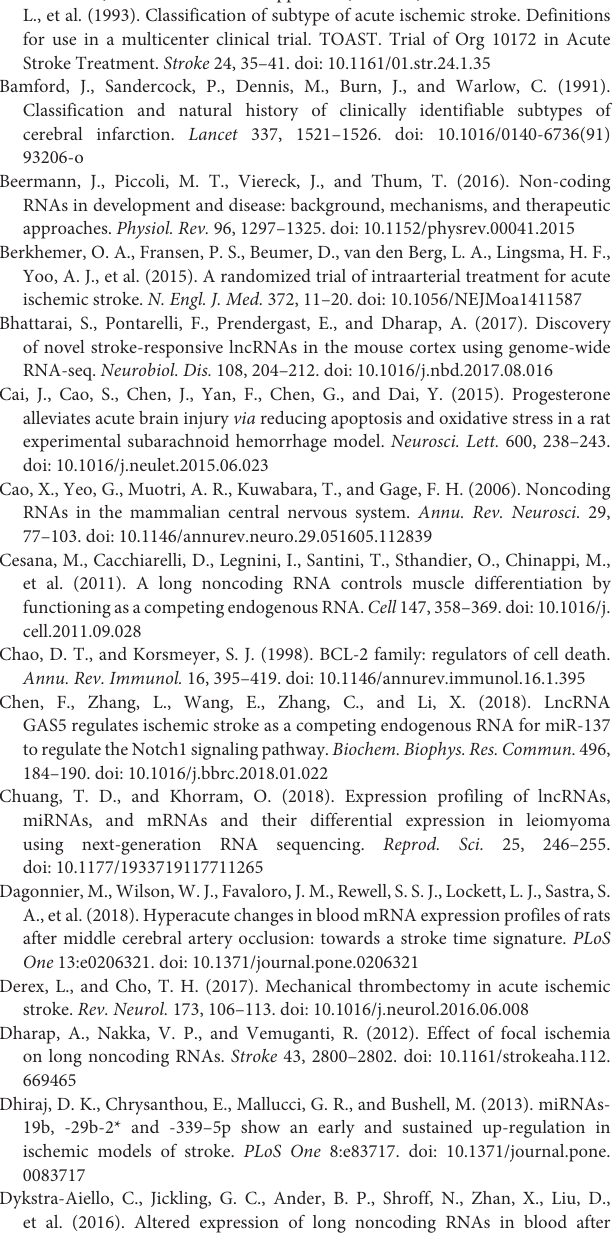
TABLE S3 | Differentially expressed mRNAs between AIS patients and healthy controls. TABLE S4 | Demographic data of AIS patients and healthy controls. TABLE S5 | Statistical analysis of lncRNA-C14orf64 qRT-PCR data. TABLE S6 | QRT-PCR data of lncRNA-AC136007.2 and statistical analysis. TABLE S7 | QRT-PCR data of